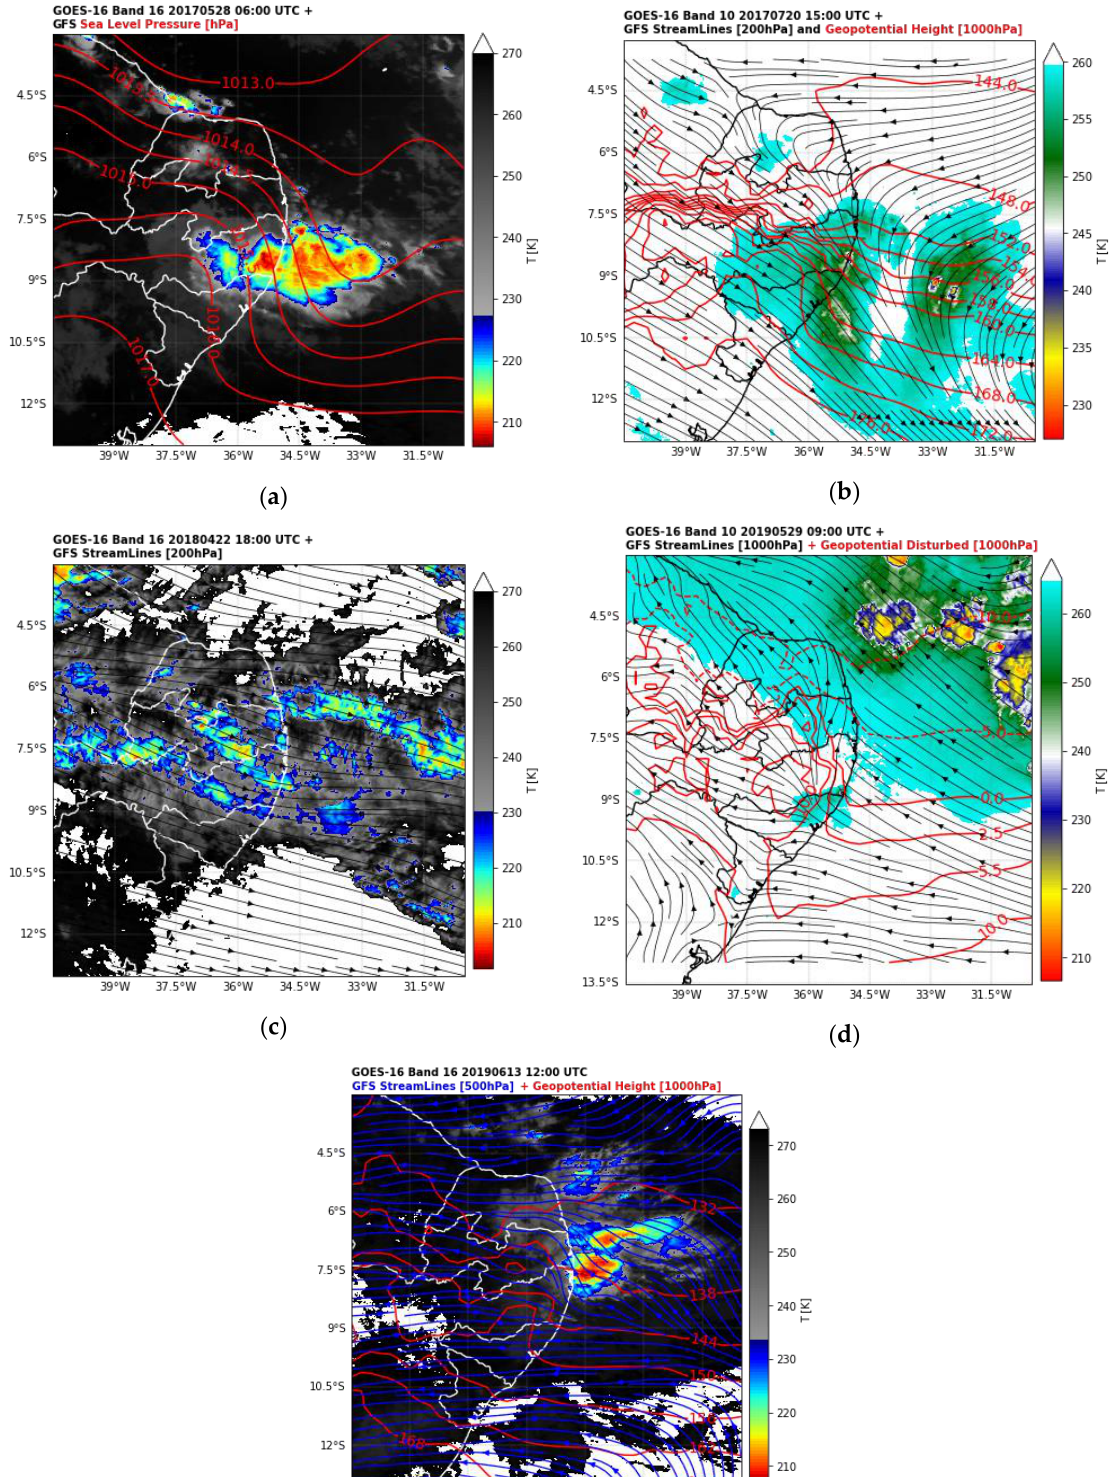
Figure 3. Synoptic and mesoscale analysis of simulated severe rainfall events: ( a ) satellite image on the enhanced infrared channel (13.3 µ) with isobars on the surface in red, ( b ) satellite image on the enhanced water vapor channel (7.4 µ), streamlines at 200 hPa, and geopotential height at 1000 hPa in red, ( c ) satellite image on the enhanced infrared channel (13.3 µ) and streamlines at 200 hPa, ( d ) satellite image on the enhanced water vapor channel (7.4 µ), streamlines at 1000 hPa, and perturbed geopotential height at 1000 hPa in red, and ( e ) satellite image on the enhanced infrared channel (13.3 µ), streamlines at 500 hPa in blue, and geopotential height at 1000 hPa in red. Events 1, 2, and 5 were associated with rainfall with large spatial extents, whereas events 3 and 4 were rainfall events concentrated in smaller regions. In events 1 through 4, strong mass divergence was observed between the 850 hPa and 600 hPa levels, generally with a maximum at the 750 hPa level, on the order of 6.0 to 10.0 × 10 − 5 s − 1 . This strong divergence in the low- to mid-level layer was almost always accompanied by convergence in the lower layer, around 900 hPa, with the maximum core on the order of − 7.5 to − 15.0 × 10 − 5 s − 1 (Figures not shown). Only event 5 did not show the pair strong divergence at me- dium levels and strong convergence at the surface. In event 1, starting on May 26 at 20UTC, the cloudiness began to intensify on the coast and subsequently expanded inland after being stationary in the coastal area all day on May 27. At high levels, there was diffluence of air currents and the proximity of the subtropical jet stream [86]. Near the surface, there was a trough parallel to the coast and an intense convergence of moisture flow from the ocean. This event showed local and synoptic scale characteristics and weak coupling between the high troposphere and the low troposphere. The intense precipitation developed mainly locally, and the main ele- ments for its maintenance were trough at low levels near the coast and strong wind runoff also in the low layer (Figure 3a). For event 2, the cloudiness was more discrete compared to the previous case. A ridge between the states of Alagoas and Pernambuco with an intense temperature gradient to the north was observed. Earlier that same day, there were upper tropospheric cyclonic vortices at an altitude [87], with a core in the state of Maranhão, and an eastern periphery influencing the coast of Pernambuco with a wind diffluence zone. In the satellite images, it was possible to observe in the water vapor channel the westward advance of two cloud cores. However, no wave characteristics were observed in low or medium levels related to the position of these cores [88]. This event was characterized by the concentration of cloudiness to the east of the surface ridge, well-related to the position of maximum pre- cipitation, and a confluence zone of high-level winds with reduced intensity compared to the previous case (Figure 3b). For event 3, the runoff in the high levels was essentially westerly, with intense cloud- iness, observed up to three days before the intense precipitation, coming from the